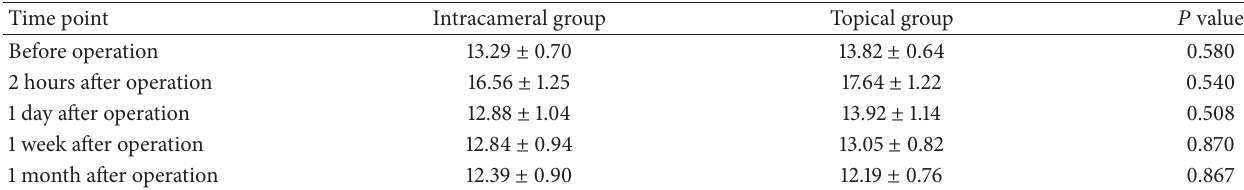
Table 3: Intraocular pressure (mmHg) at different time points in the two groups. Time point Intracameral group Topical group Before operation